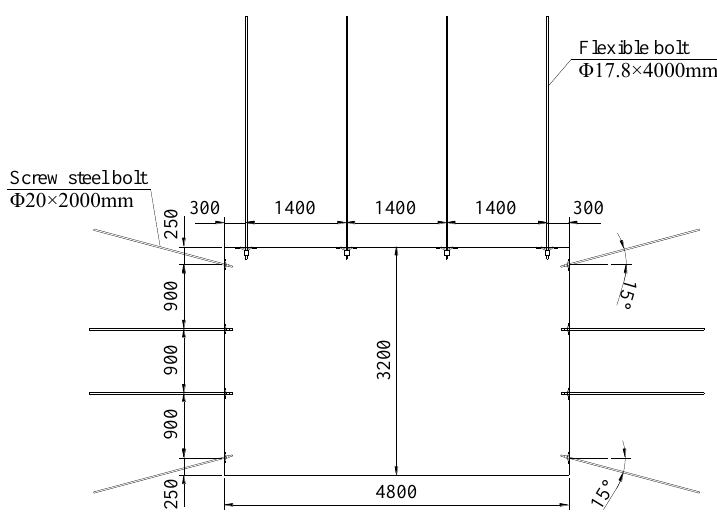
Figure 15. Support design of the testing roadway.